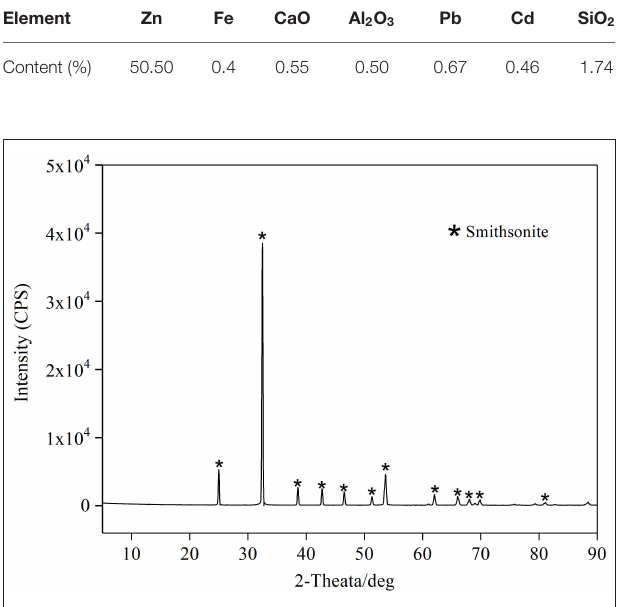
FIGURE 1 | X-ray diffraction pattern of the pure smithsonite